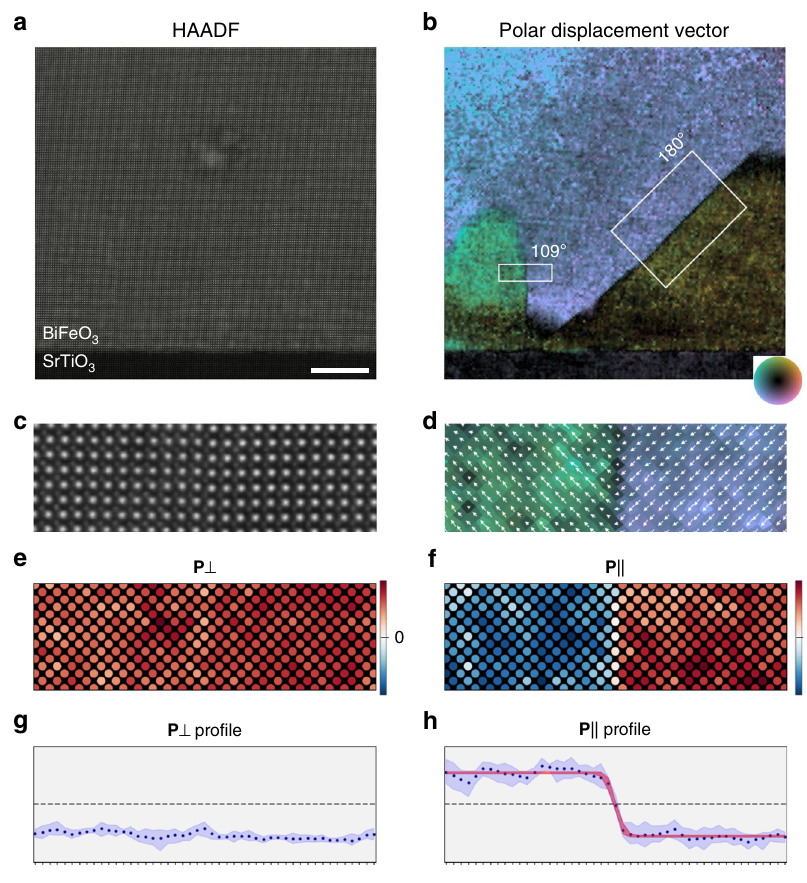
Fig. 2 Experimental data for full-dataset and 109° domain wall. a , b HAADF-STEM of polydomain BiFeO 3 thin fi lm with magni fi ed ( c – h ) 109° domain wall region. a HAADF-STEM of BiFeO 3 fi lm on SrTiO 3 substrate, scalebar 10 nm. b Cation polar displacement vector, P , map, white rectangles depict subregion datasets bisecting 109° and 180° domain walls. c Subregion 109° domain wall in HAADF and ( d ) displacement vector maps. e Color-scaled lattice positions of the P component perpendicular ([100] psuedocubic axis) and ( f ) parallel ([001] pc ) to the domain wall. g Pro fi les of the mean values (datapoints) and 90% data bounds (blue) for perpendicular and ( h ) parallel P components. The red band corresponds to the 90% highest posterior density interval for the Bayesian analysis Model